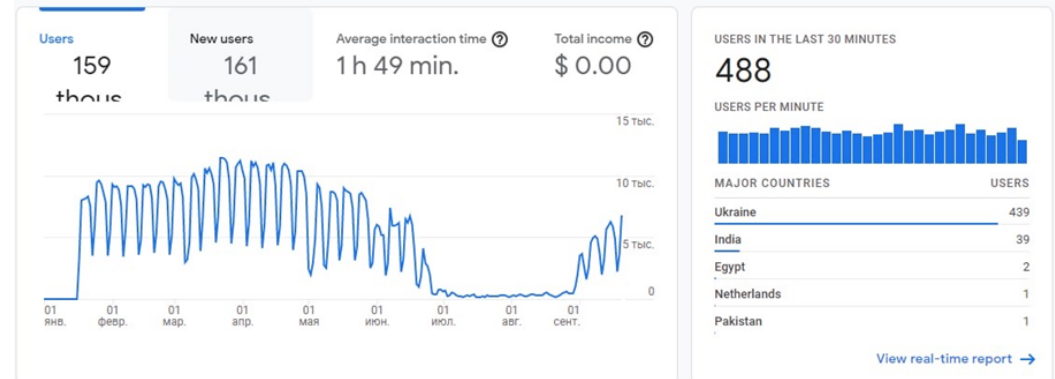
Figure 3: Attendance statistics of the LIKAR NMU distance learning platform.